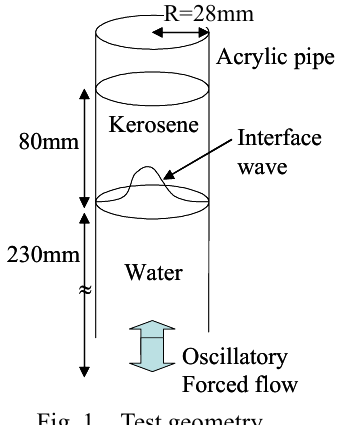
Fig.2 Liquid film formation on the wall during ascending motion of